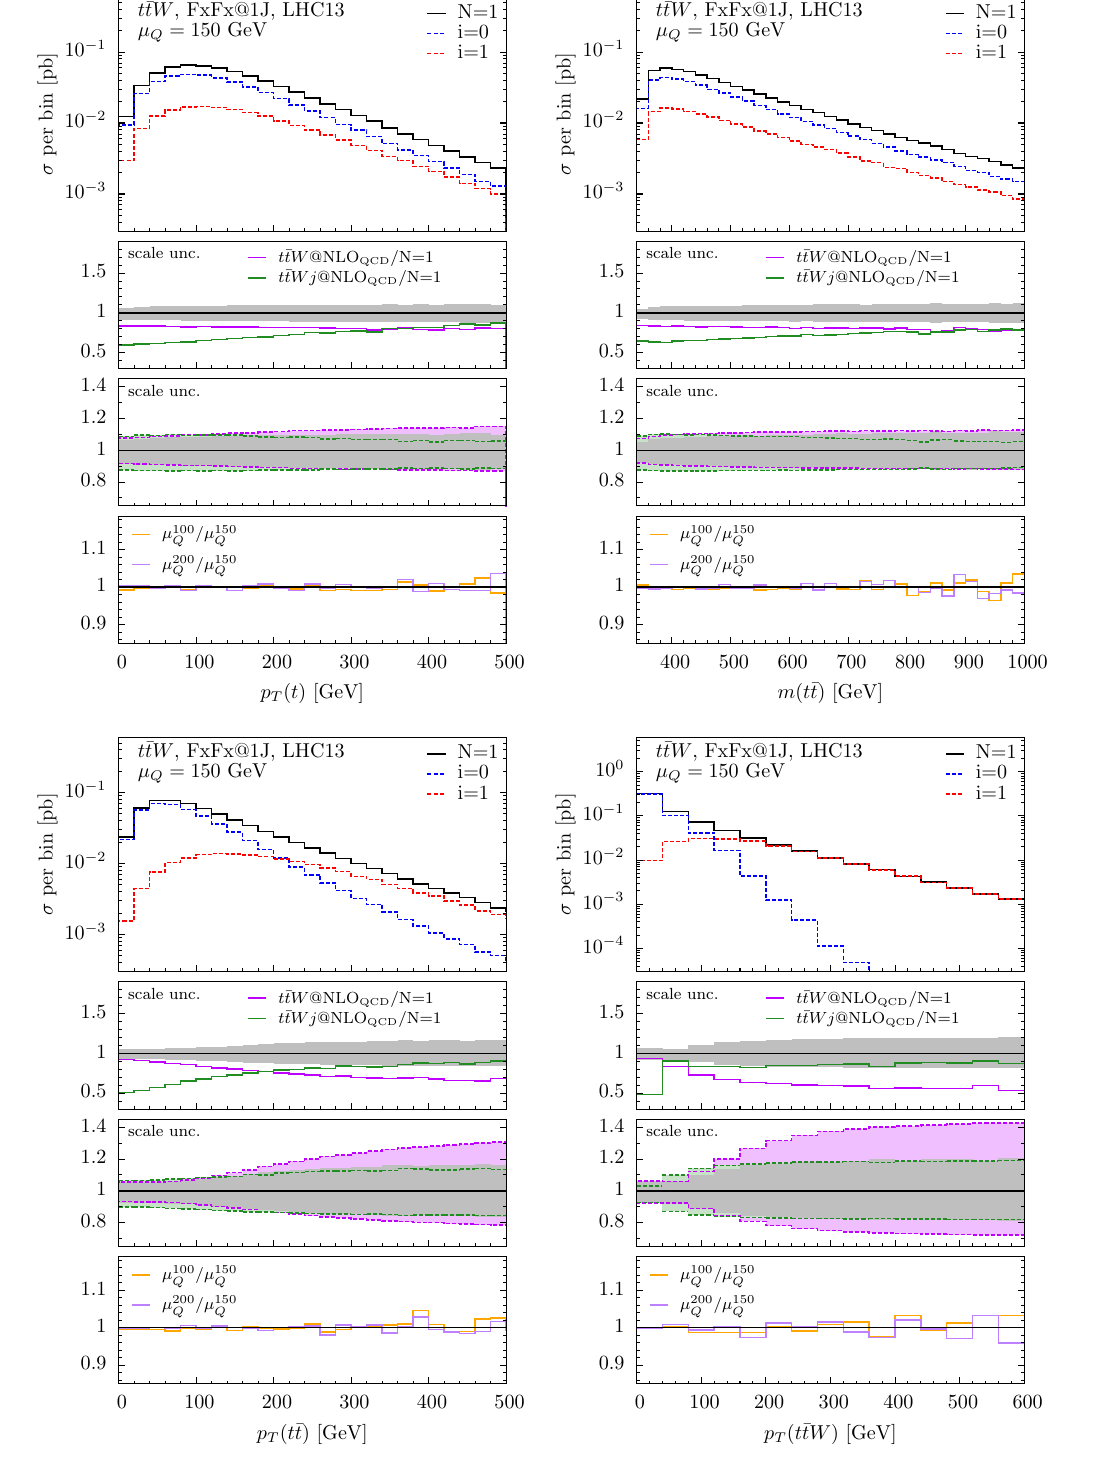
Figure 4 . Differential distributions for the t ¯ tW FxFx merged sample using µ Q = 150 GeV as merging